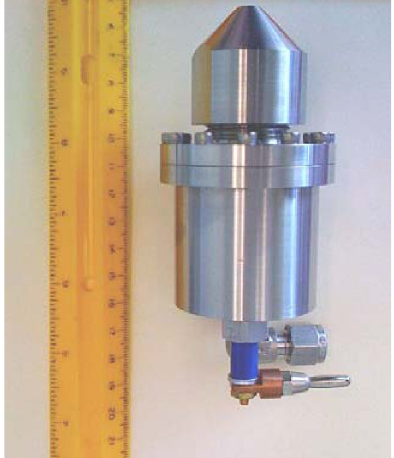
FIG. 2. Photograph of assembled valve.